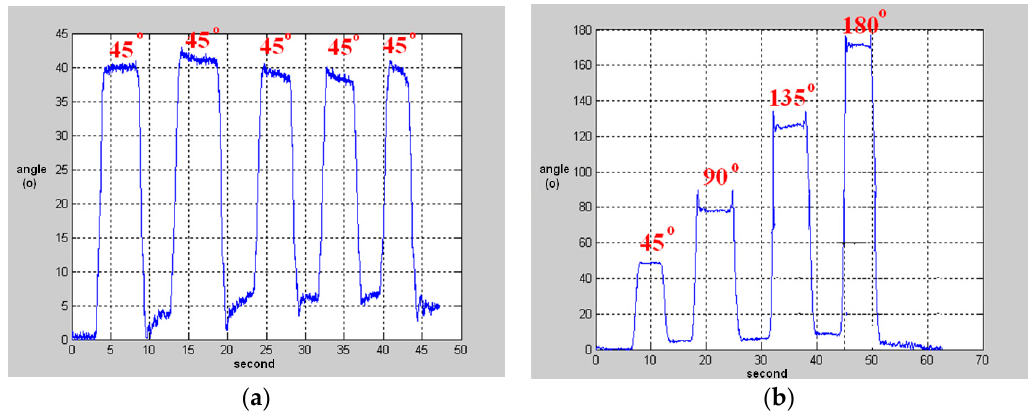
Figure 9. Variations of tilt angles between two motes for ( a ) flexing to the elbow (left); ( b ) raising the arm (right) [60].